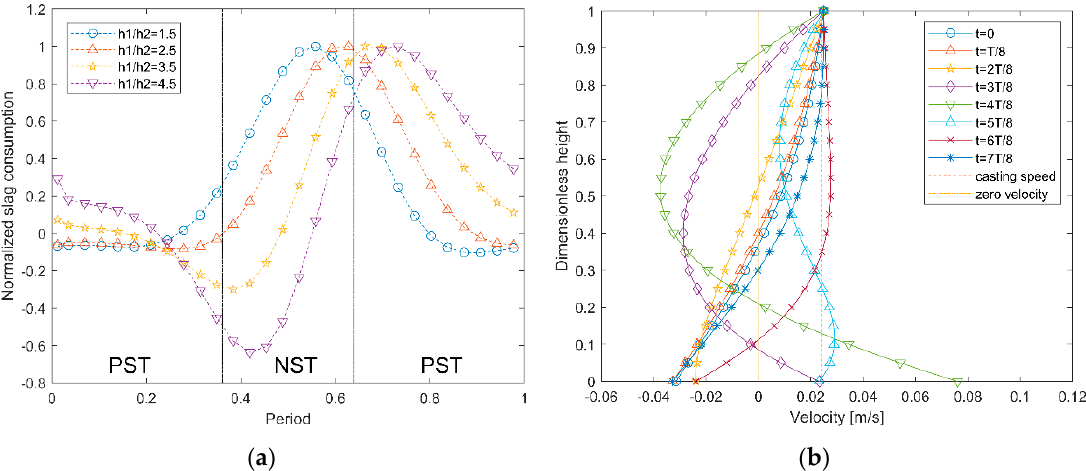
Figure 15. ( a ) Normalized slag consumption during the oscillation cycle with different thickness ratios ( h 1 ( x = 0 ) / h 2 ( x = L ) ) and ( b ) transient velocity profiles for h 1 / h 2 = 4.5 at meniscus ( x = 0).